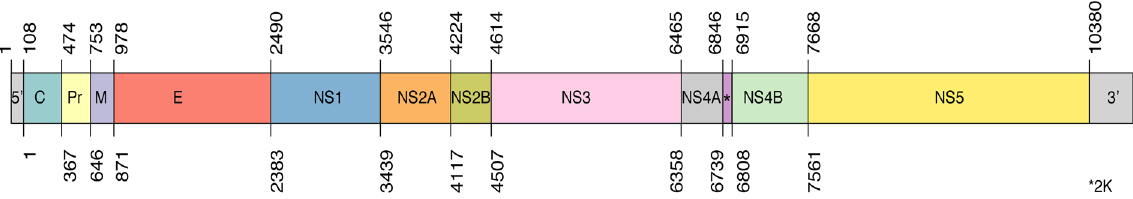
Fig 1. Visual representation of the correct genome annotation for the proposed ZIKV reference sequence KJ776791[10]. The figure shows the corrected nucleotidepositionsfor the Genbank annotationof KJ776791.This correction was guidedby the curated annotationof NC_012532 [4]. The upper axis indicatesnucleotide positionsof proteins in the full-lengthgenome(10,807 nt), including the 5’UTR (length of 107 nt) and 3’UTR (length of 428 nt). The lower axis indicatesnucleotidepositionsof encodedproteins in the CDS (amino acids: 1–3,423; nucleotides: 1–10,269). These positions also apply as the correct annotation of the WHO candidate reference genomeKX369547.While the reference sequencewe proposeencompasses the completeUTR, we note that the lengths of the 5’UTR and 3’UTR of the WHO candidate reference sequenceKX369547are limited to 90 nt and 406 nt,